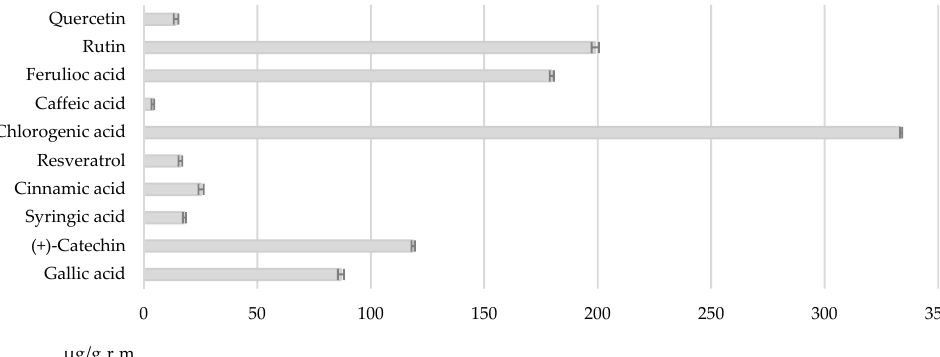
Figure 1. Quantification of phenolic compounds assessed for the r.m. The percentages calculated for the phenolic compounds analyzed were: 33.53% for chlorogenic acid, 19.98% for rutin, 18.06% for ferulic acid, 11.93 for (+)-catechin, 8.72% for gallic acid, 2.53% for cinnamic acid, 1.62% for resveratrol, 1.80% for syringic acid, 1.43% for quercetin, and 0.40% for caffeic acid. 3.2. Analysis of Capsules 3.2.1. Average Mass and Uniformity of Mass Given that all the analyzed capsules fell into the ±7.5% deviation regarding the av- erage mass and uniformity of mass (Table 3), it can be concluded that the analyzed cap- sules comply to the requirements of the European Pharmacopoeia. Table 3. Average mass and uniformity of mass assessment. Capsule No.